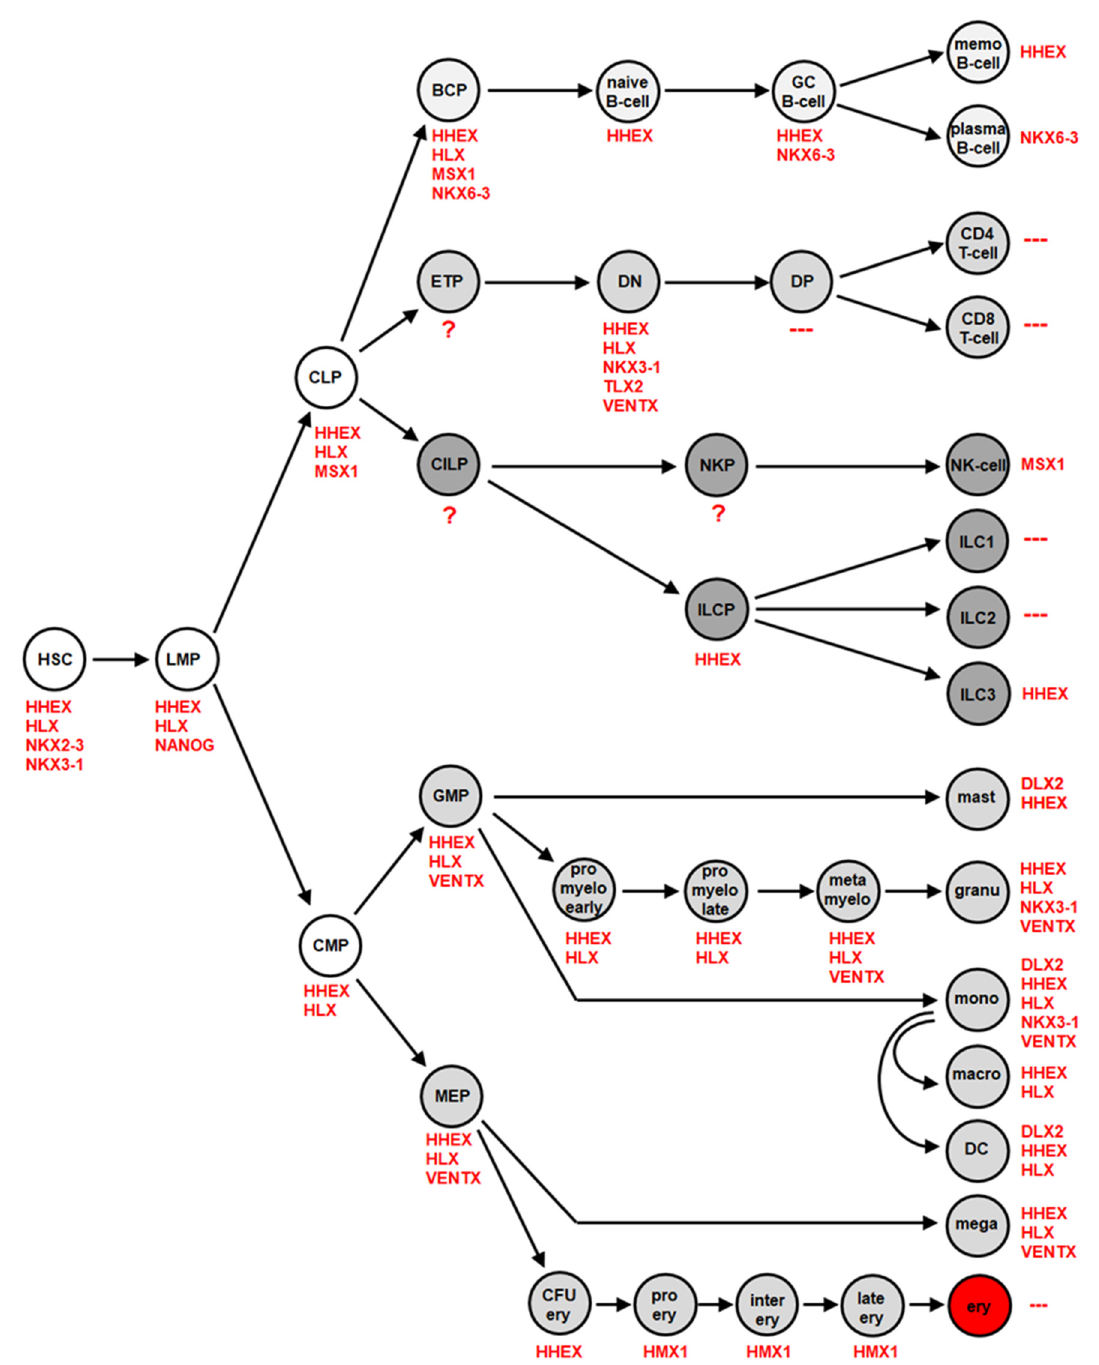
Figure 3. The NKL-code in hematopoiesis This diagram depicts activities of NKL homeobox genes during early hematopoiesis, in lymphopoiesis including the development of T-cells, B-cells, NK-cells and ILCs, and in myelopiesis. Each cell/stage is labelled with the accordingly expressed NKL homeobox genes. BCP: B-cell progenitor, CILP: common innate lymphoid progenitor, CLP: common lymphoid progenitor, CMP: common myeloid progenitor, DC: dendritic cell, DN: double negative, DP: double positive, ETP: early T-cell progenitor, GC B-cell: germinal center B-cell, GMP: granulocytic- monocytic progenitor, HSC: hematopoietic stem cell, ILC(P): innate lymphoid cell (progenitor), LMP: lymphoid and myeloid primed progenitor, memo B-cell: memory B-cell, MEP: megakaryocyte-erythroid-progenitor. Of note, this code was generated analyzing expression profiling and RNA-seq